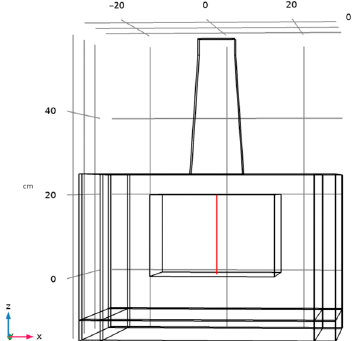
Figure 6. Acquisition of midline temperature values for the soil model.